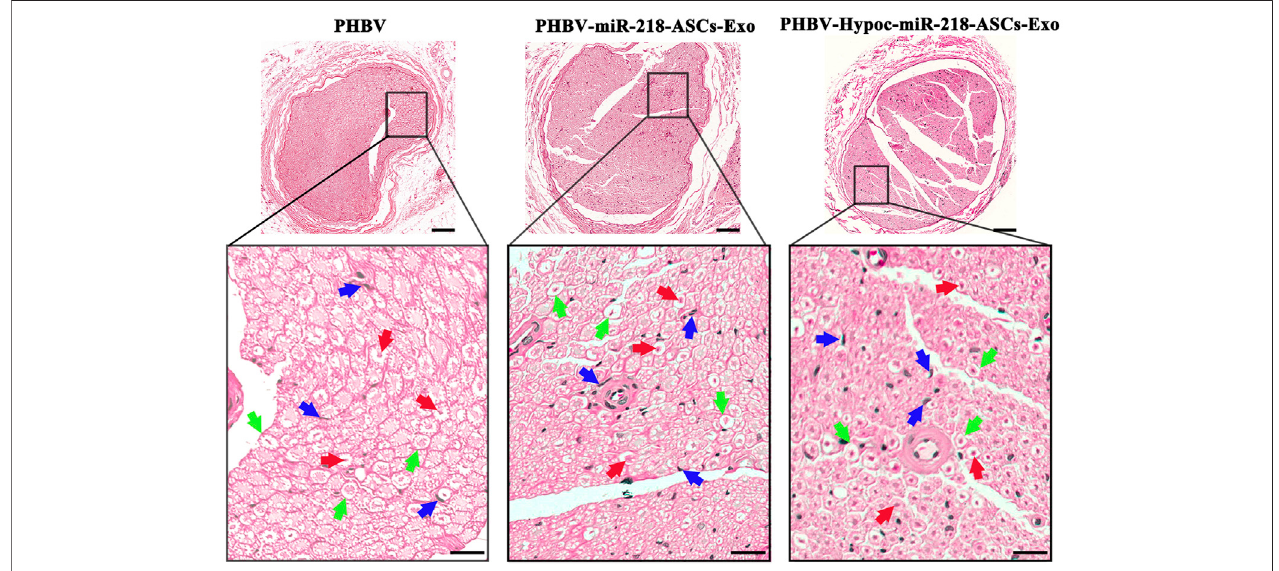
FIGURE 14 | H&E staining of regenerated nerve tissue (scale bars = 100 μ m), and red arrows pointed out axon, blue arrows pointed out SCs nucleus, and green arrows pointed out myelin sheath in regional enlarged drawing (scale bars = 20 μ m).